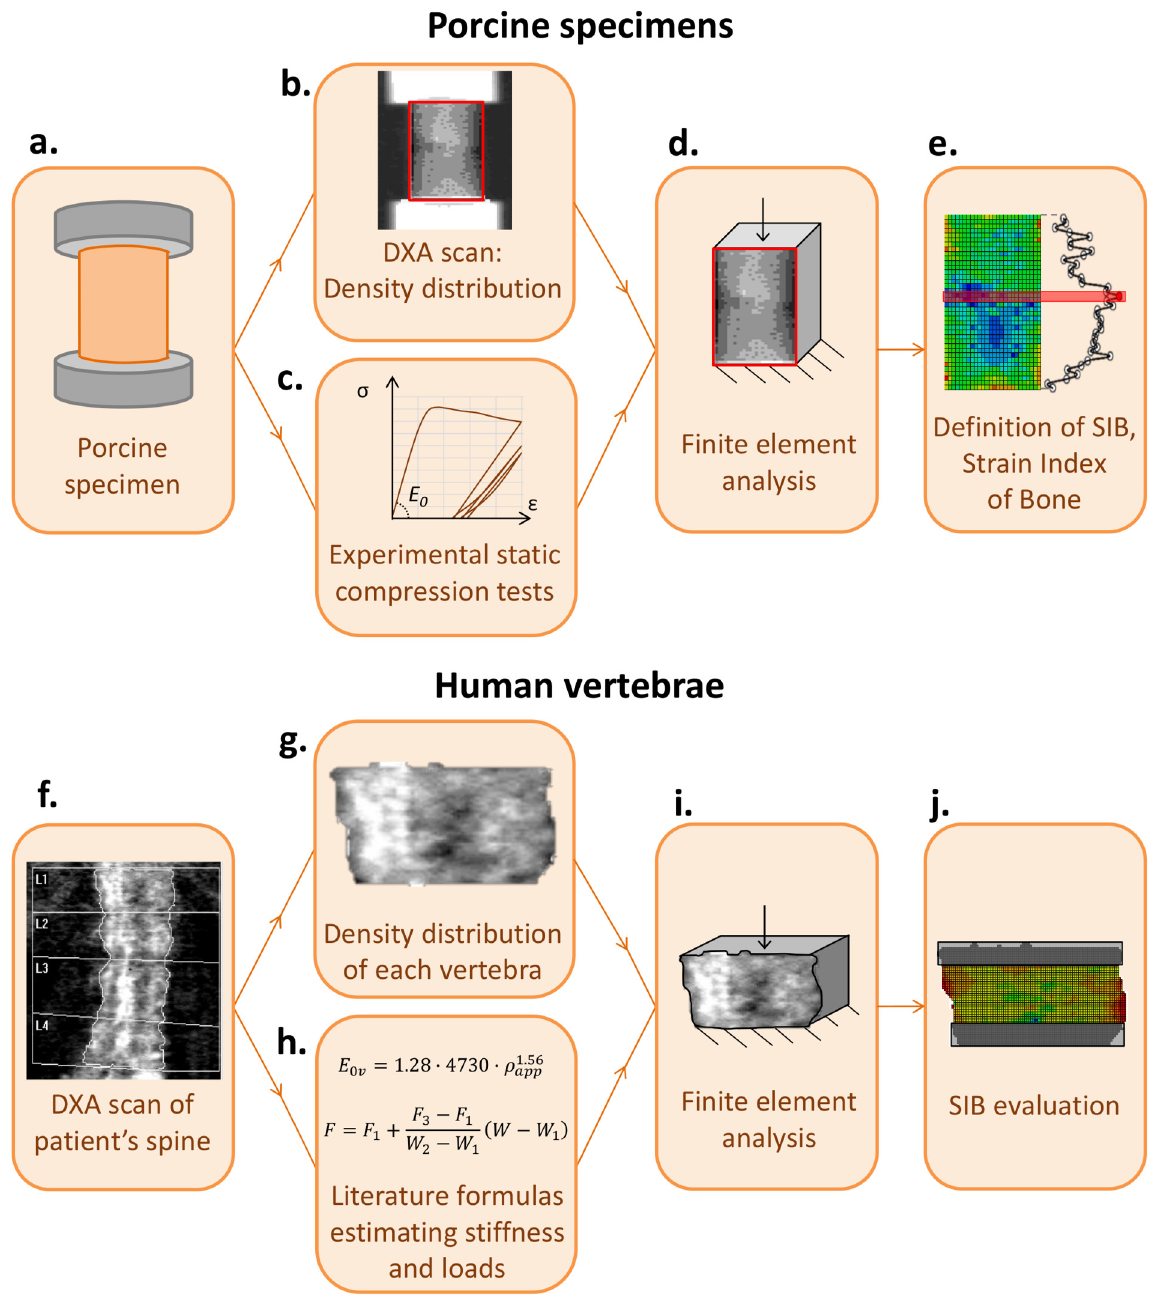
Fig 1. Scheme of the adopted procedures for porcine bone specimens (a. to e.) and for human vertebrae (f. to j.). Porcine bone specimens: a) Cylindrical sample of trabecular bone obtained from porcine vertebrae and embedded into aluminium endcaps. b) Greyscale 2D-image of density distribution obtained from DXA scanning. c) Experimental compressive testing on bone samples. d) FE-analyses on simplified sample geometry and DXA-based stiffness distribution. e) Definition of the Strain Index of Bone ( SIB ) based on the outcome of the numerical analyses. Human vertebrae: f) DXA scan of the spine, evidenced with a white border, 1 pixel thick. g) Greyscale 2D-image of the density distribution of a single vertebra, obtained from DXA scanning. h) Selection of literature formulas to estimate stiffness and loads from the density. i) FE-analyses on simplified sample geometry and DXA-based stiffness distribution. e) estimation of SIB based on the outcome of the numerical analyses.